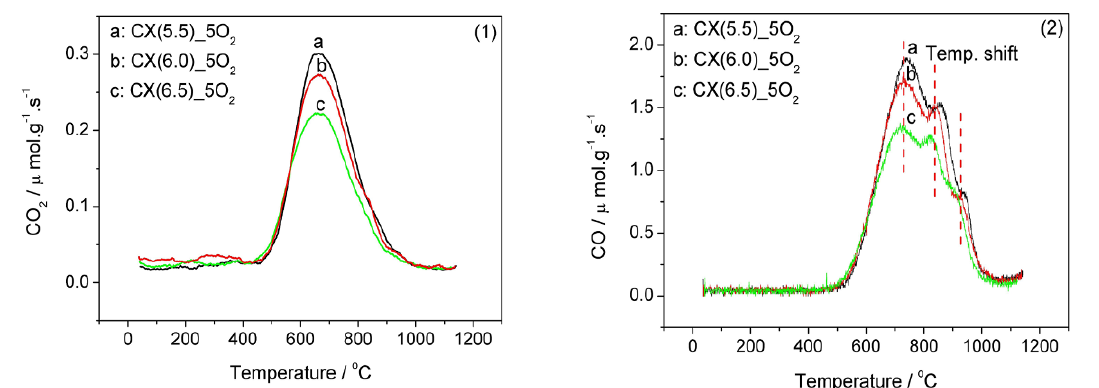
Figure 2. TPD spectra measured from the activated carbon xerogels: (1) CO